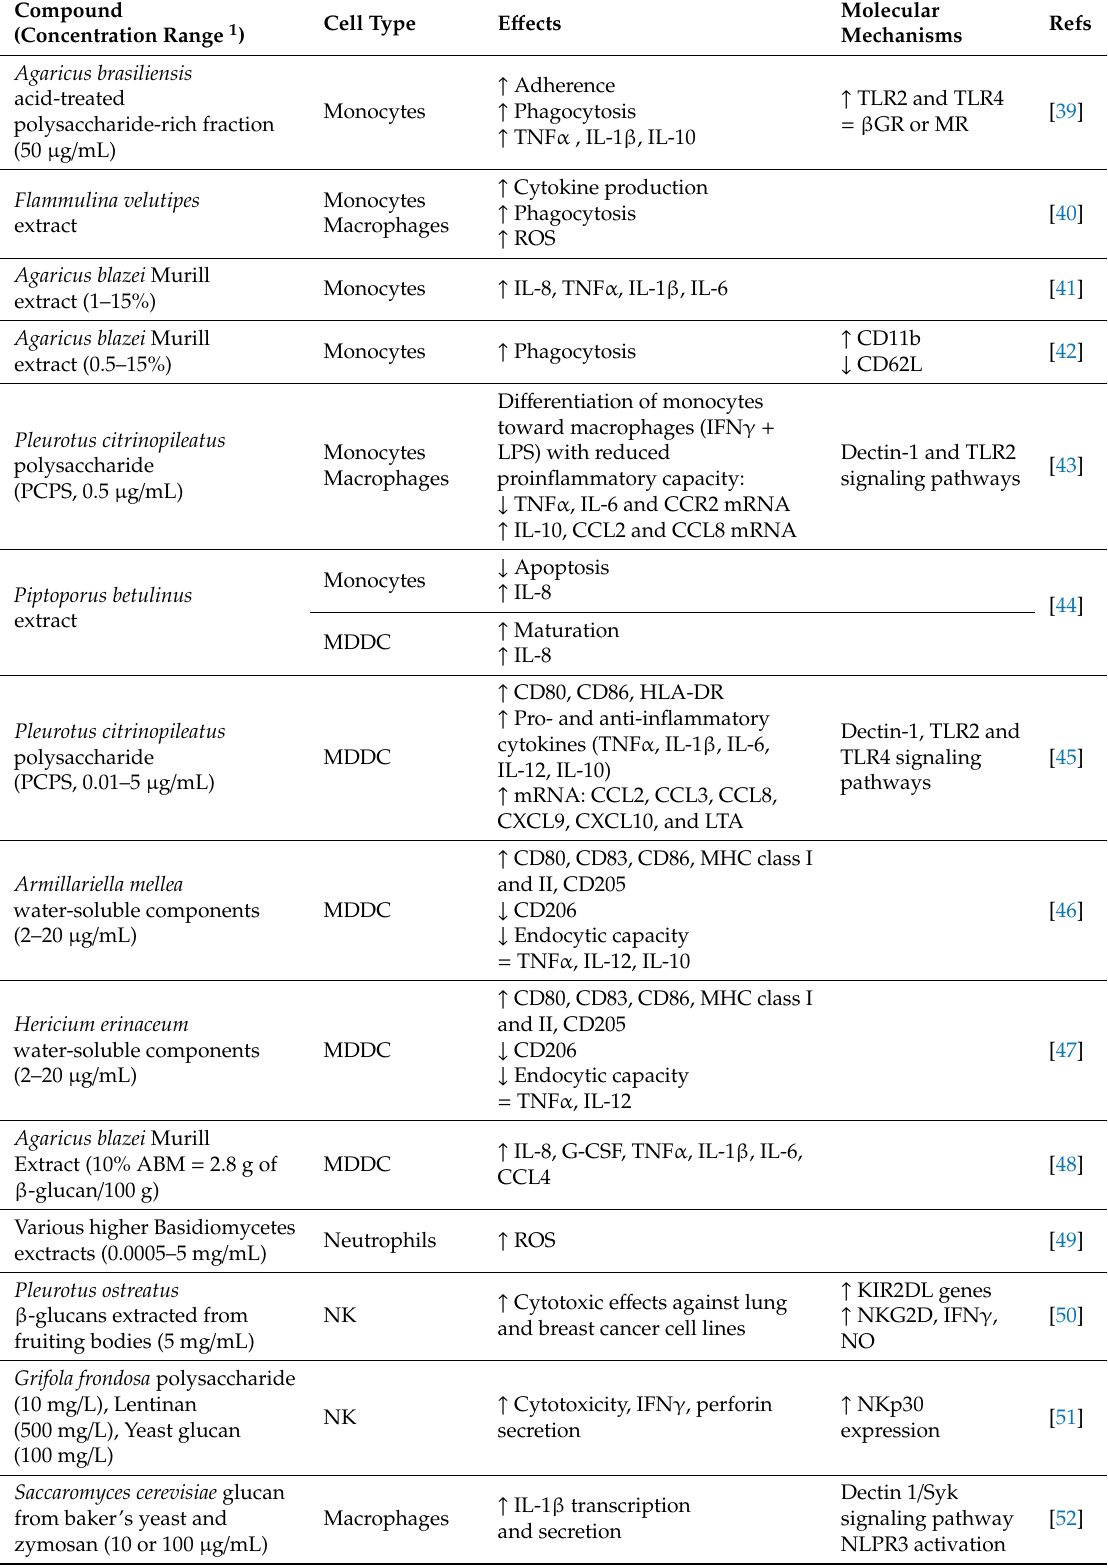
Table 1. In vitro studies evaluating the immunomodulatory e ff ects of β -glucans on human innate immunity